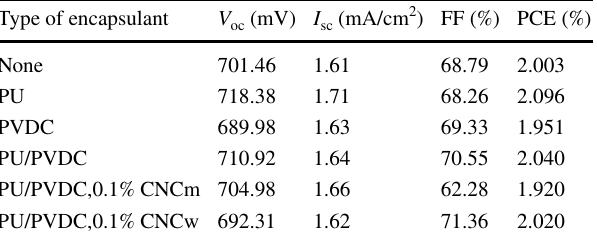
PU/PVDC,0.1% CNCw